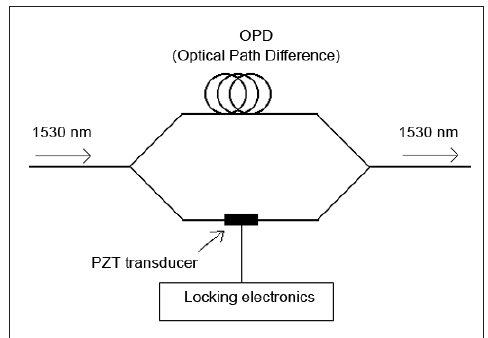
Fig. 5. The Mach-Zender